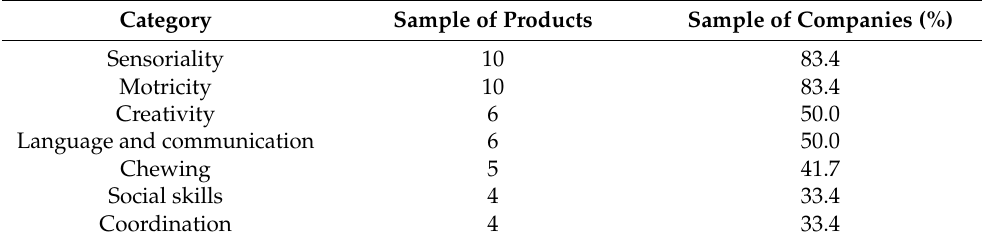
Table 13. Most common ASD needs-based toy categories.